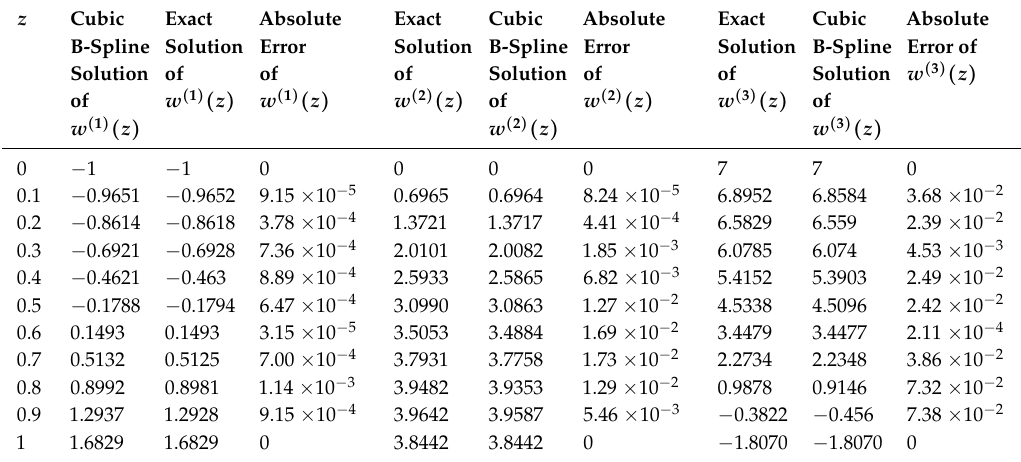
where boundary conditions are defined in Problem 3. 10